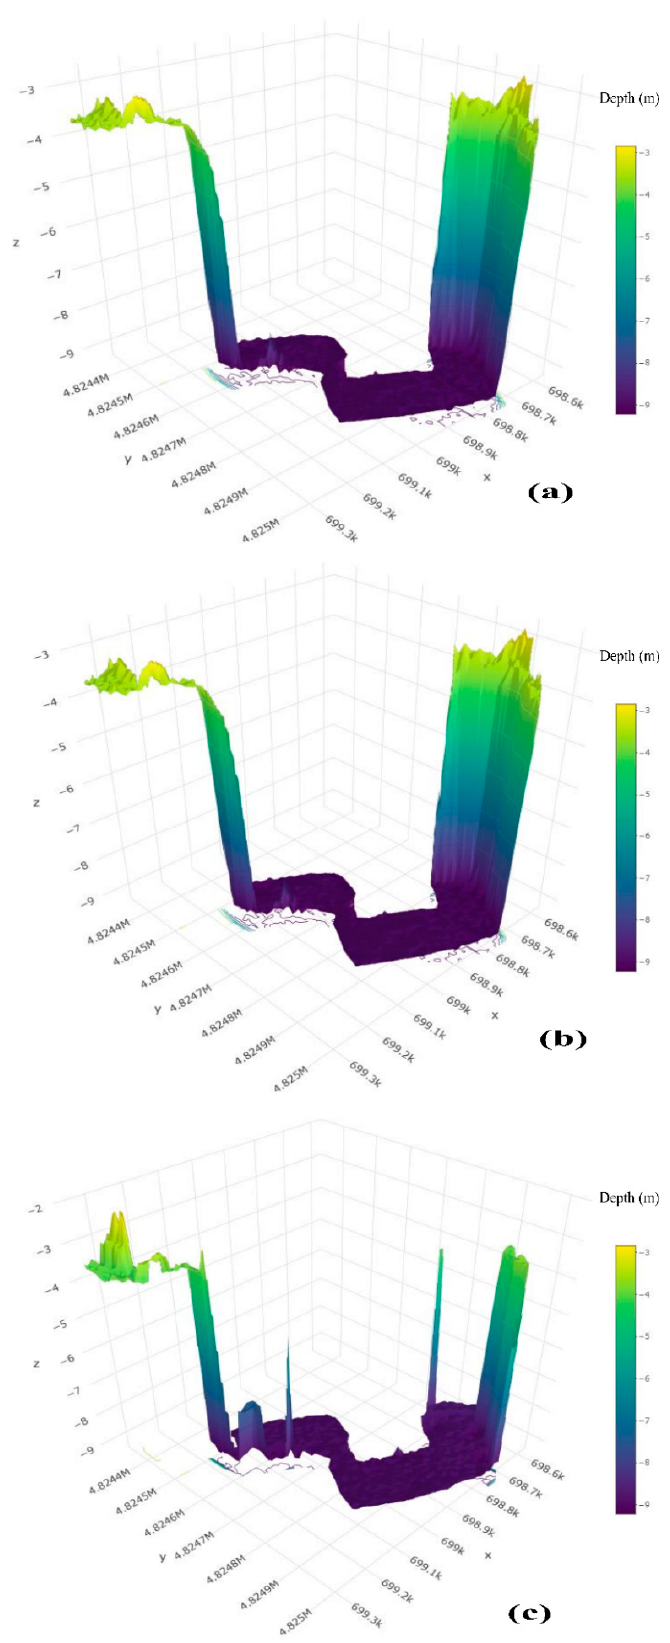
Figure 4. 3D bathymetries. Dates: ( a ) 21/11/17, ( b ) 21/12/17 and ( c ) 24/02/18.